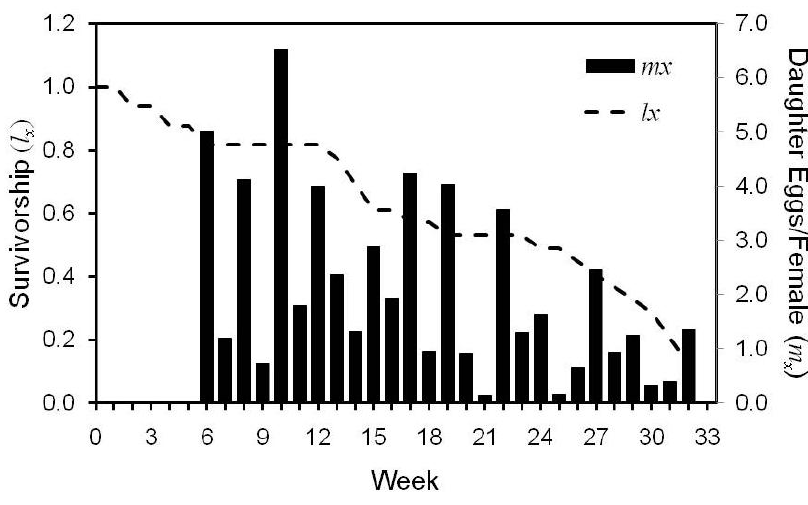
Figure 1. Survivorship curve ( l ) and the number of daughter eggs produced weekly by x each female ( m ) of the pyrethroid-resistant Richmond (RR) bed bug x